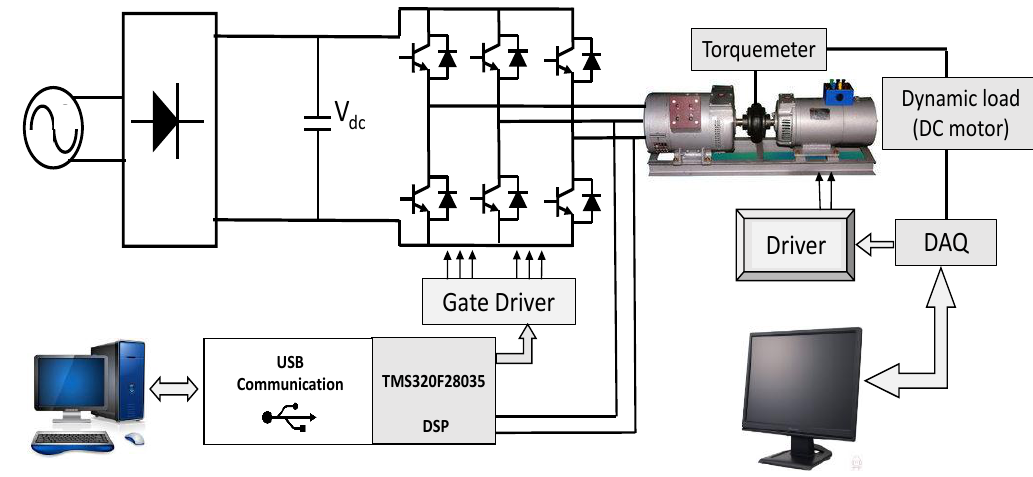
Figure 6. Complete system scheme used to test and validate the algorithm and testbench to simulate different load resistances.